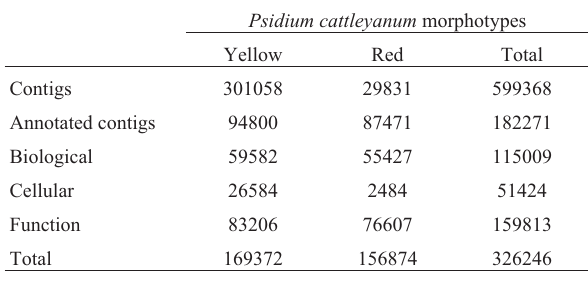
Figure 5 - Total clusters up- and down-regulated in each comparison of leaf vs unripe fruit, leaf vs ripe fruit and unripe vs ripe fruit of each morphotype of P. cattleyanum